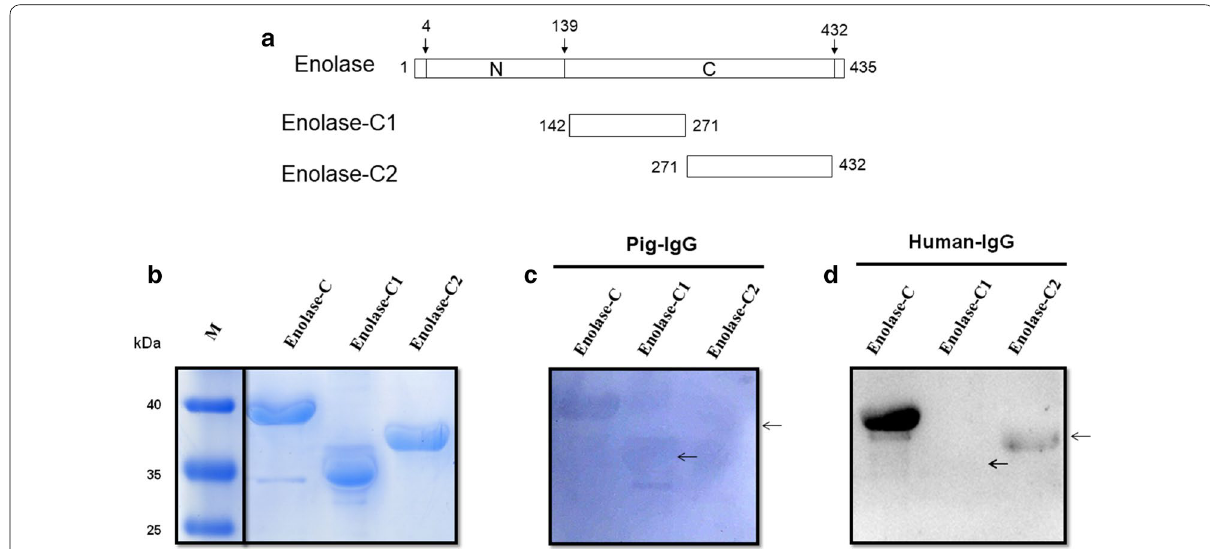
Fig. 5 Characterization of enolase truncations that interact with pIgG or hIgG. a Schematic representation of two deletion constructs Enolase-C1 and Enolase-C2. b SDS-PAGE analysis of recombinant Enolase-C, Enolase-C1, and Enolase-C2. c Far-western blot analysis of Enolase-C and its truncations incubated with pIgG. d Far-western blot analysis of Enolase-C and its truncations incubated with